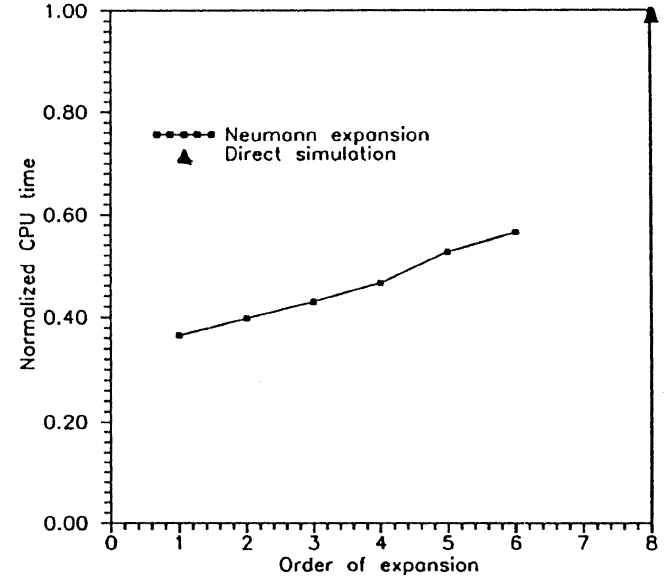
Fig. 9. Comparison of normalized CPU time of the plate